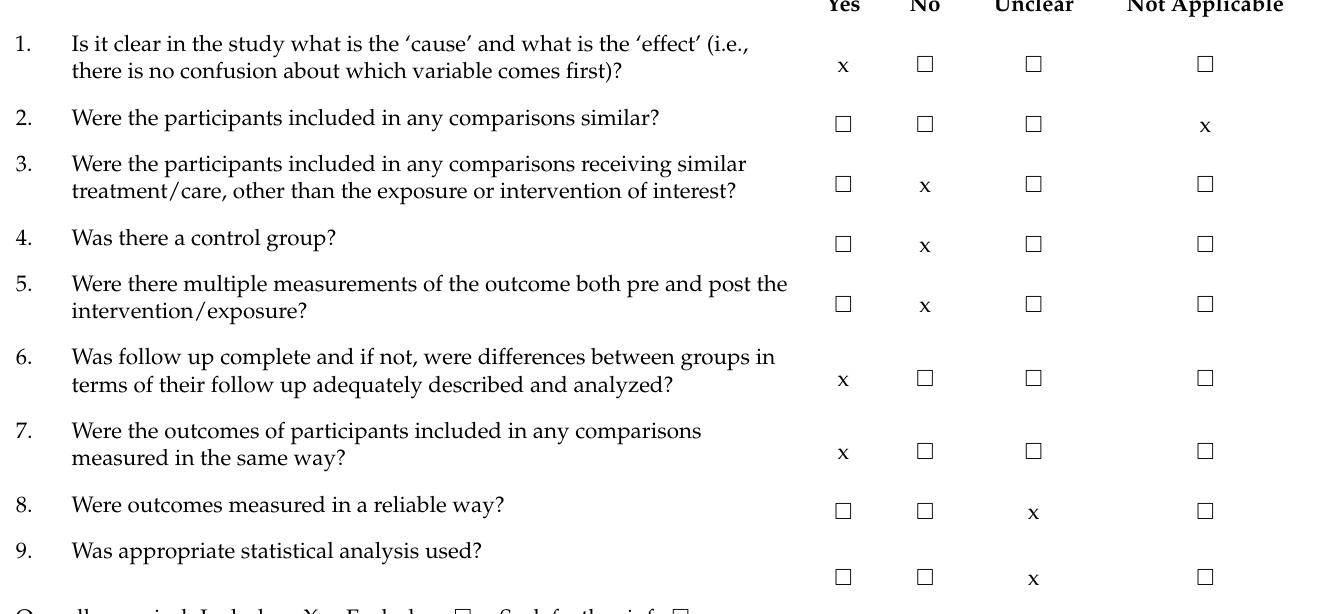
Yes No Unclear Not Applicable